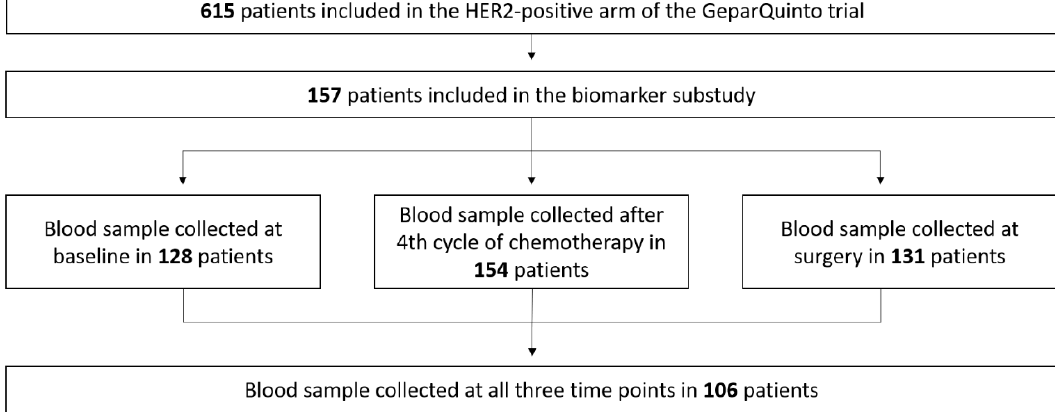
Figure 1. Serum collection in the HER2-positive cohort in the GeparQuinto trial.Abbreviations: EC–epirubicin / cyclophosphamide, T–docetaxel, H–trastuzumab, L–lapatinib.